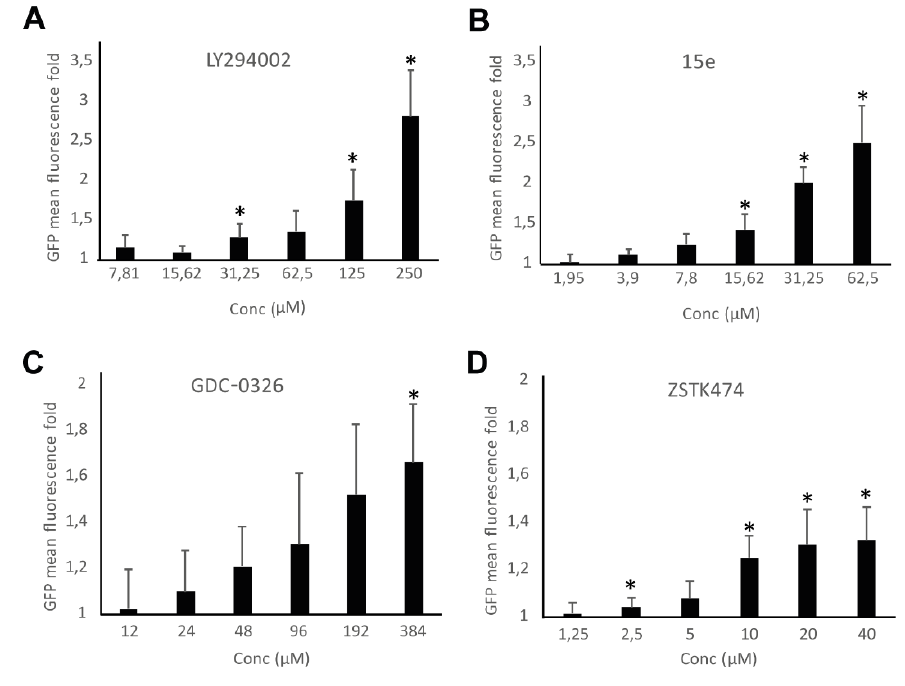
tration of compound tested